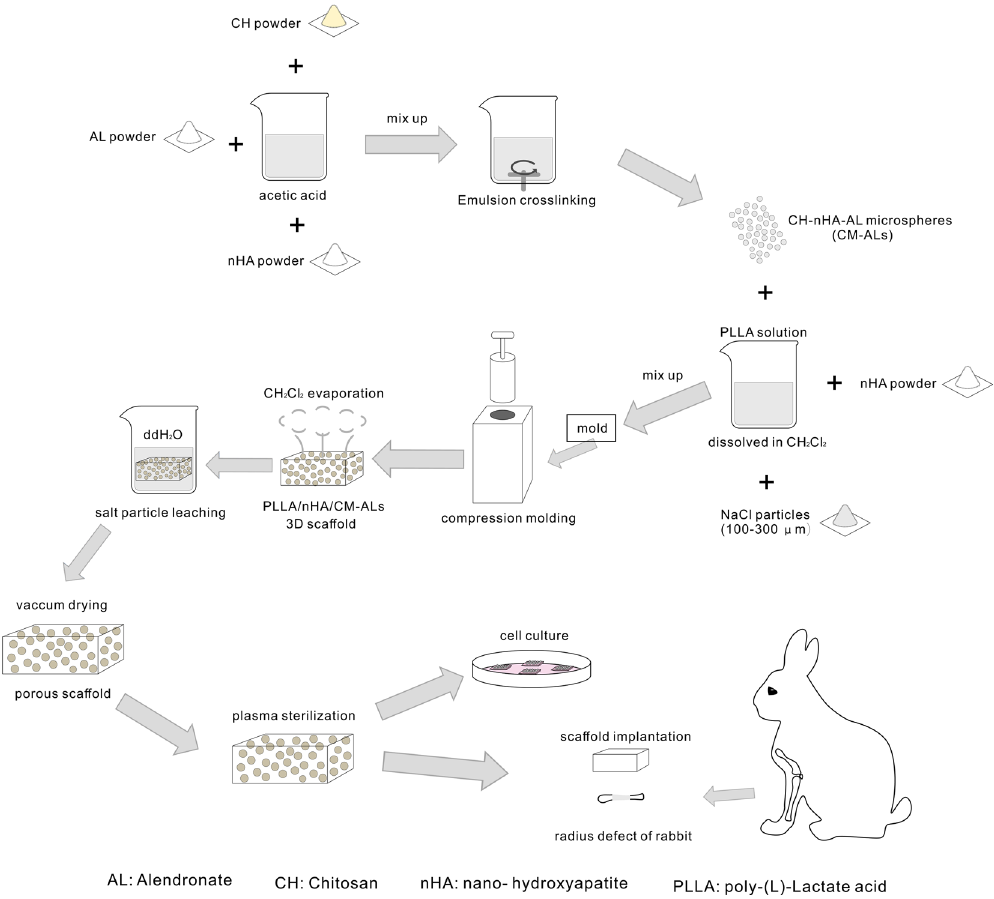
Figure 7. Schematic illustration of preparation of PLLA/nHA/CM-AL scaffolds for bone regeneration in a rabbit model of large segmental bone